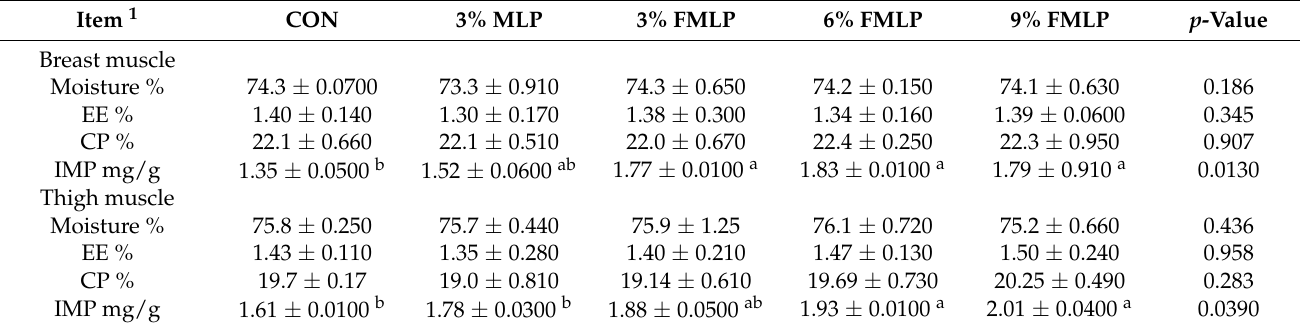
Table 9. Effects of FMLP on chemical composition and IMP content in muscle of